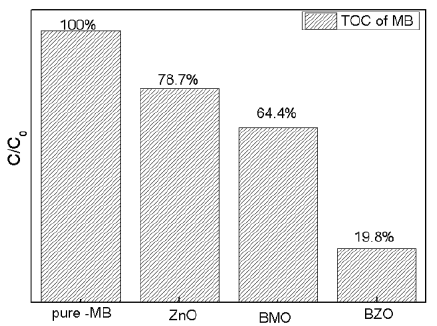
Figure 11. TOC analysis of different systems.